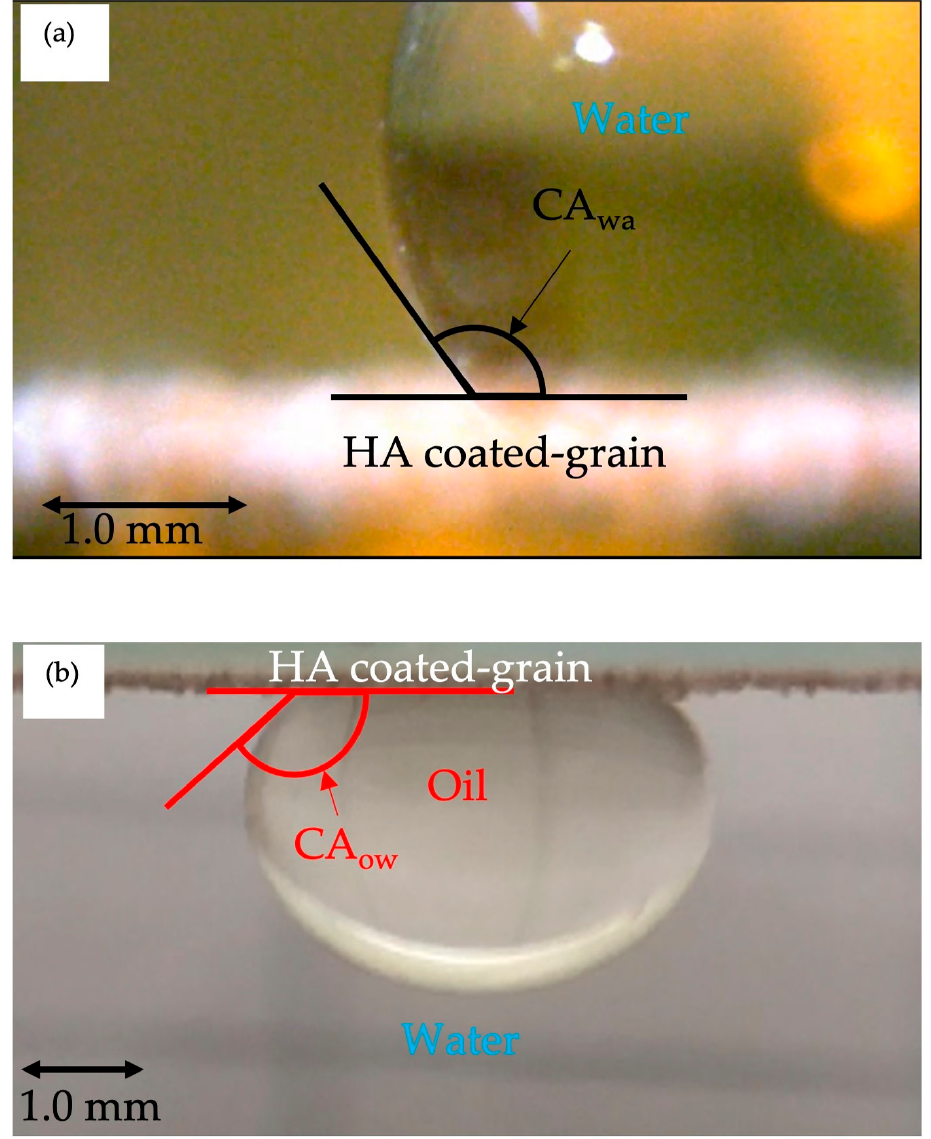
Figure 2. Sessile droplet method to measure contact angles: ( a ) Water in air (CA wa ); ( b ) Oil in water (CA ow